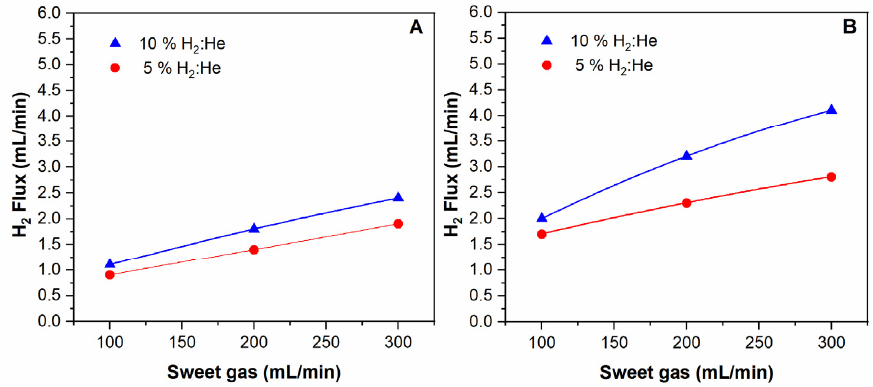
Figure 7. H 2 permeated flux rate of the composite membrane as a function of the sweep gas flow for mixtures H 2 /He at: 400 °C ( A ) and 450 °C ( B ).